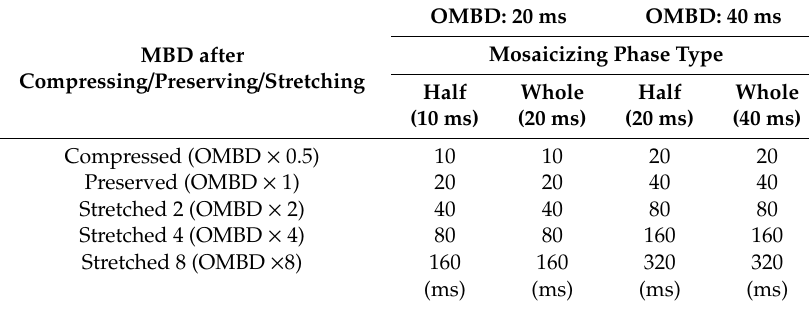
Table 2. Mosaic speech block durations used in the